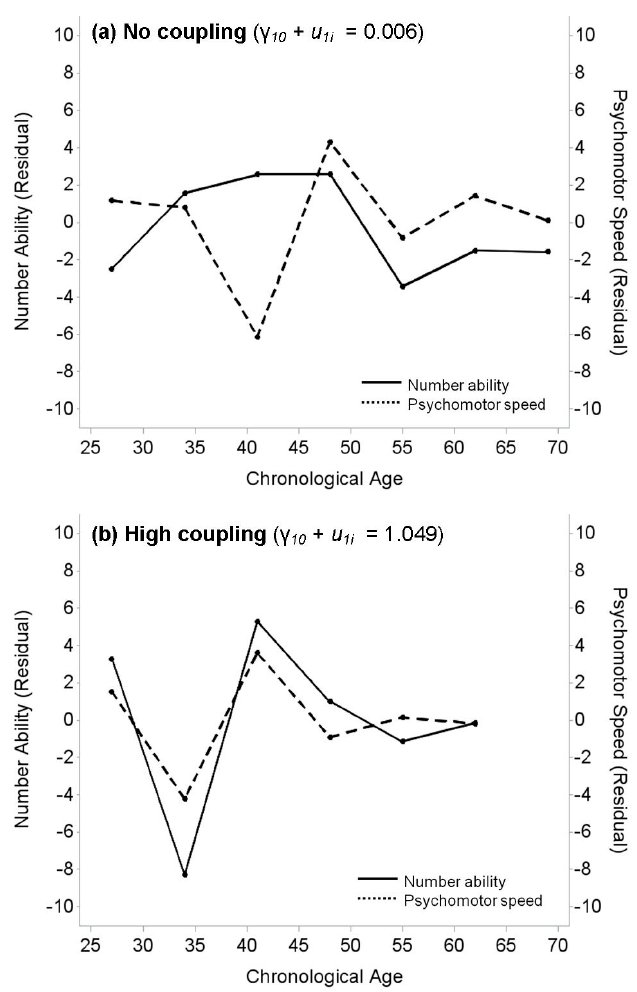
Figure 2. Detrended time series of psychomotor speed and number ability for two participants. ( a ) No coupling from psychomotor speed to number ability ( γ 10 + u 1 i = 0.006); ( b ) high level of coupling from psychomotor speed to number ability ( γ 10 + u 1 i = 1.049).